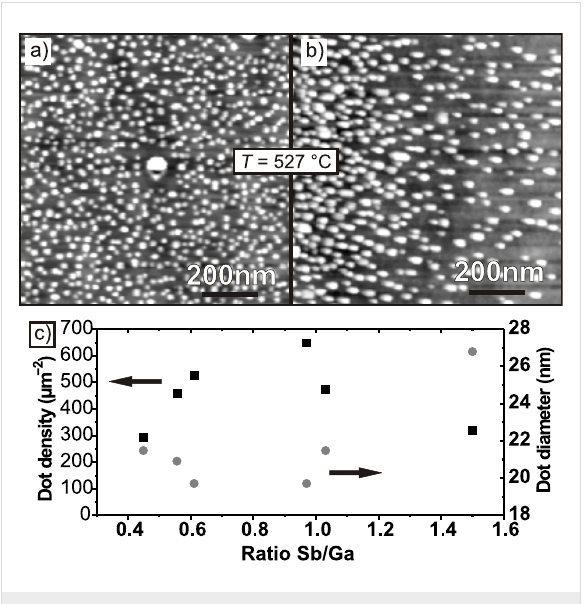
Figure 1: Top: AFM images of samples grown at a temperature of T = 527 °C and a nominal coverage of 3 ML, but with different V/III ratios: a) 0.97/1 and b) 1.5/1; c) dot density and diameter plotted against V/III ratio.